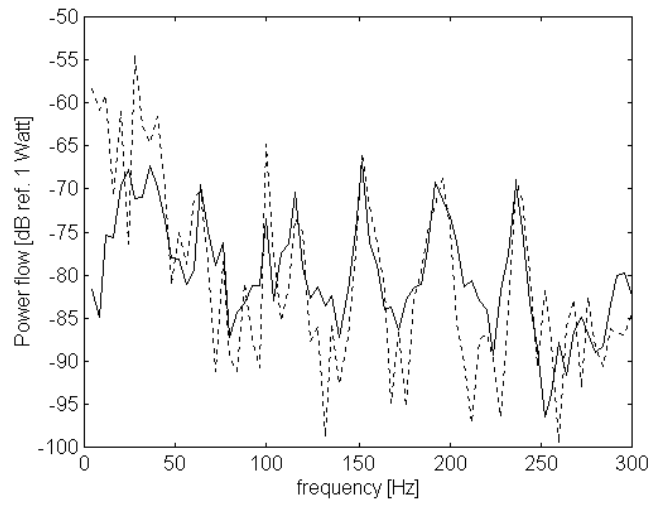
Fig. 5. Input power versus active SI – LDV. — Input power; ··· active